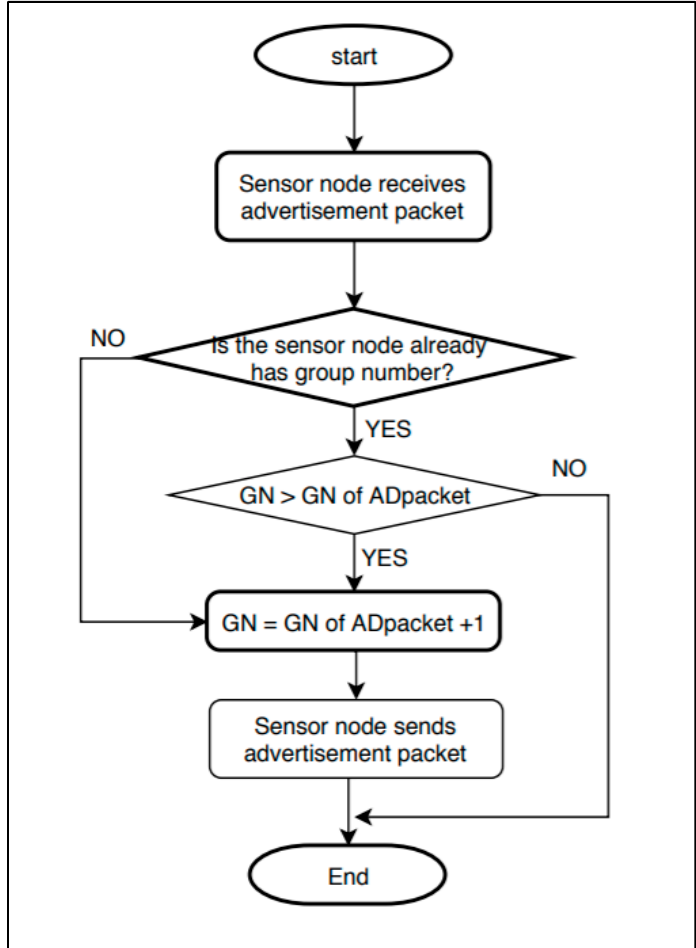
Figure 2. Initial group number setting flowchart.